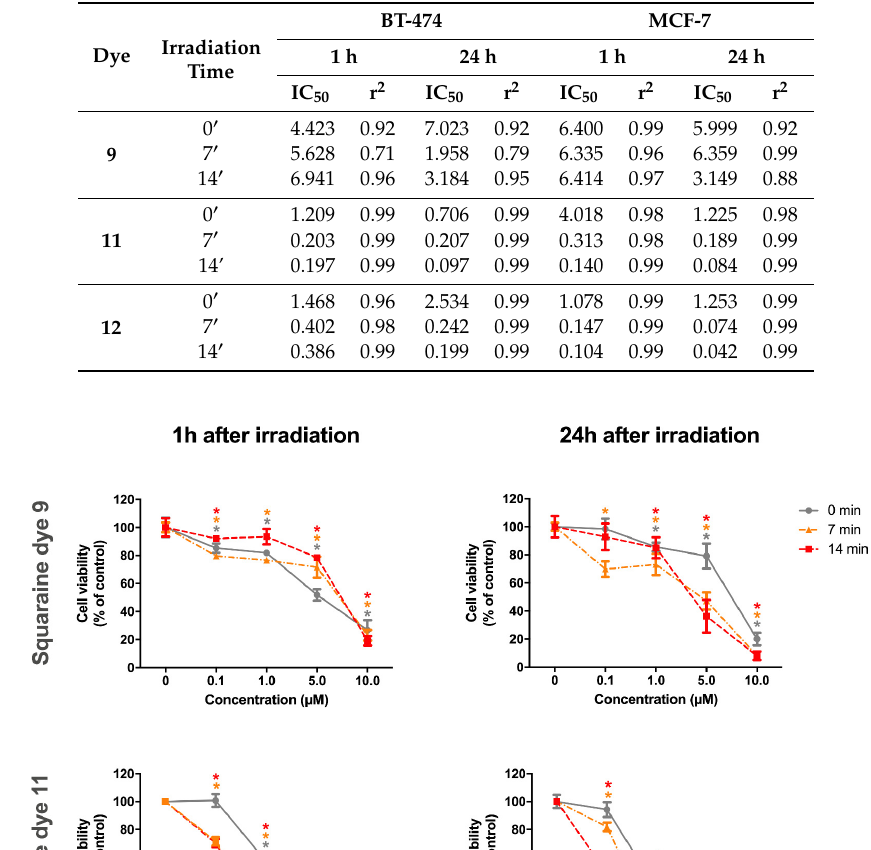
Table 4. Estimated half-inhibitory concentration values (IC 50 values, in µ M) and coe ffi cient of their determination (r 2 ) for the quinoline- and benzoselenazole-derived unsymmetrical squaraine cyanine dyes 9 , 11 and 12 in BT-474 and MCF-7 cells exposed to 0, 7 or 14 min of light-emitting diode irradiation and 1 or 24 h of incubation with the irradiated dyes.